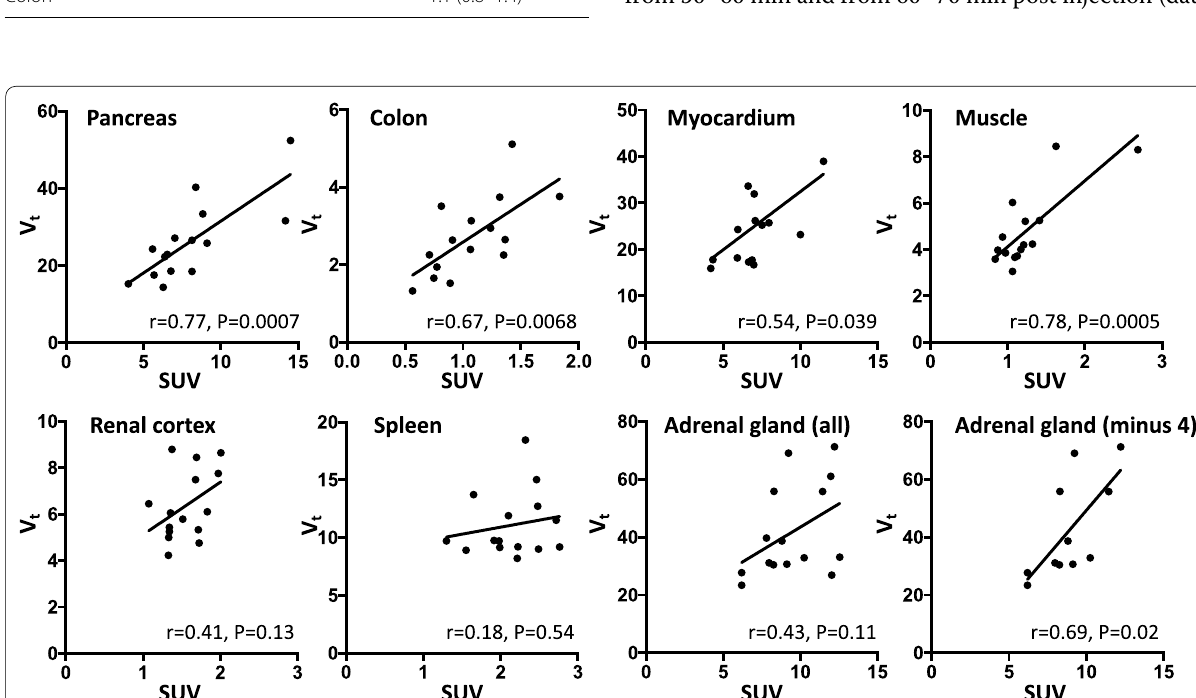
Fig. 4 Total volume-of-distribution ( V t ) from 1-tissue compartment model versus SUV values from 50 to 70 min post injection. Data are shown with best fitted line (least squares) for visual